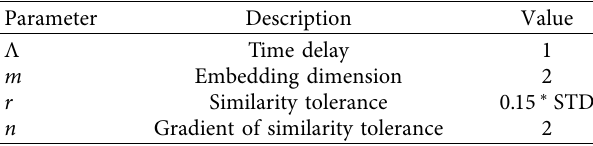
Table 4: Parameter settings of the FE method.